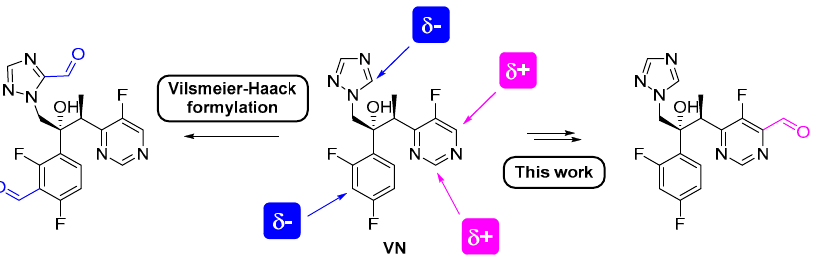
Figure 3. Hypothetical Vilsmeier–Haack formylation sites versus this regioselective two-step methodology.